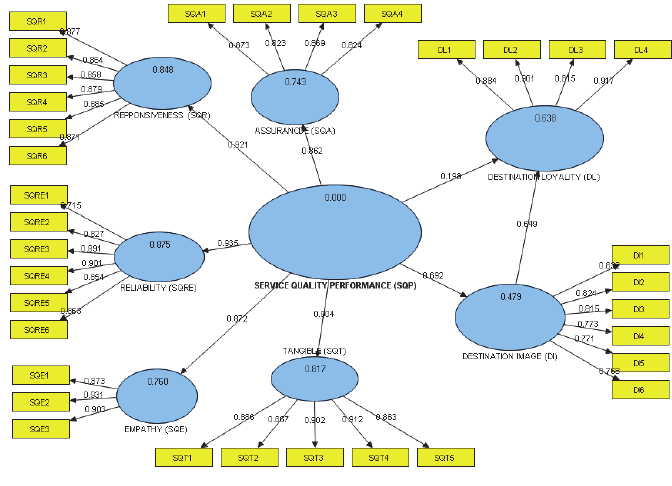
Fig. 2 . Variable Coding Tree